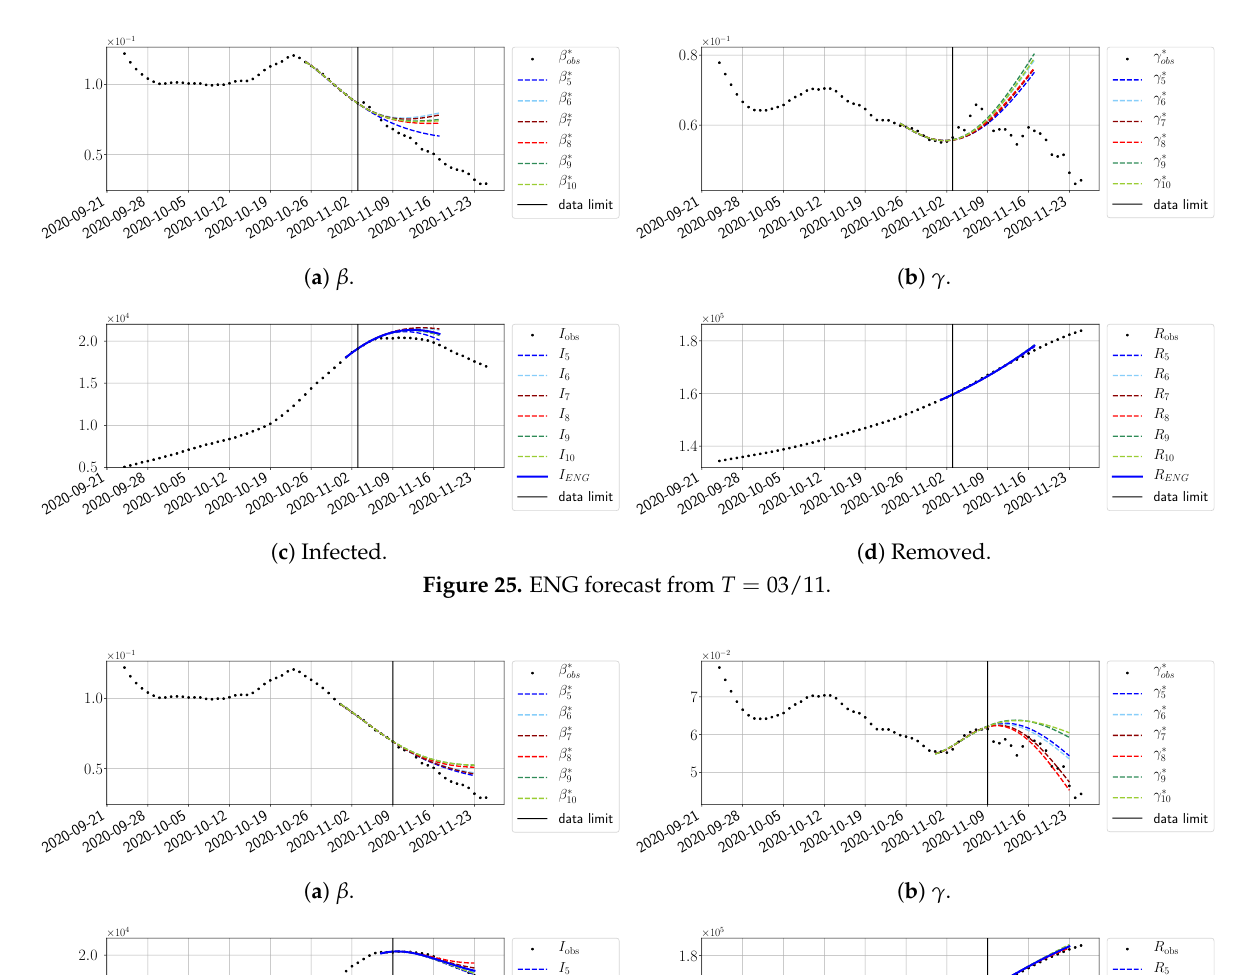
Figure 26. ENG forecast from T =